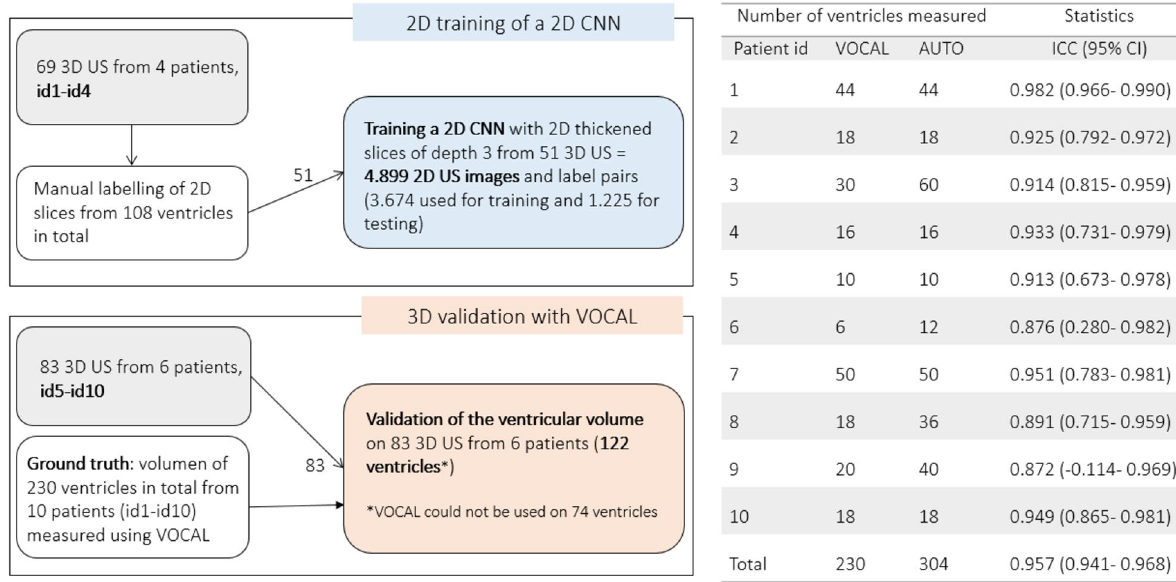
Figure 9. Left, description of the dataset and how it was distributed for training and testing the deep learning framework and for its validation against the gold standard (VOCAL). Right, the table shows the number of ventricles measured using VOCAL and/or the deep learning-based segmentation method and the intraclass coefficient (ICC) between both methods. Using VOCAL, there are situations in which the ventricles cannot be measured. For instance, in patients id3, id6, id8 and id9 the number of unmeasured ventricles reached 50% and the ICC is lower. Using deep learning, all ventricles from the ten patients could be